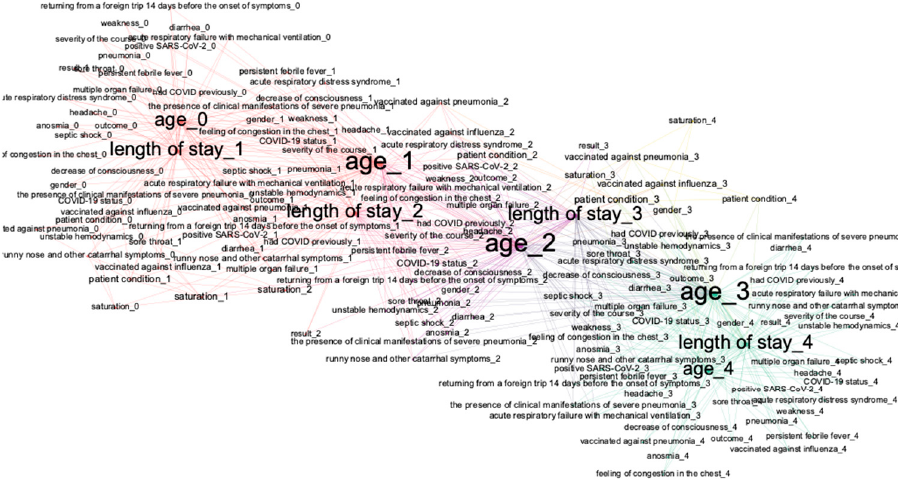
Figure 8. DAG for DBN for predicting treatment outcomes and length of